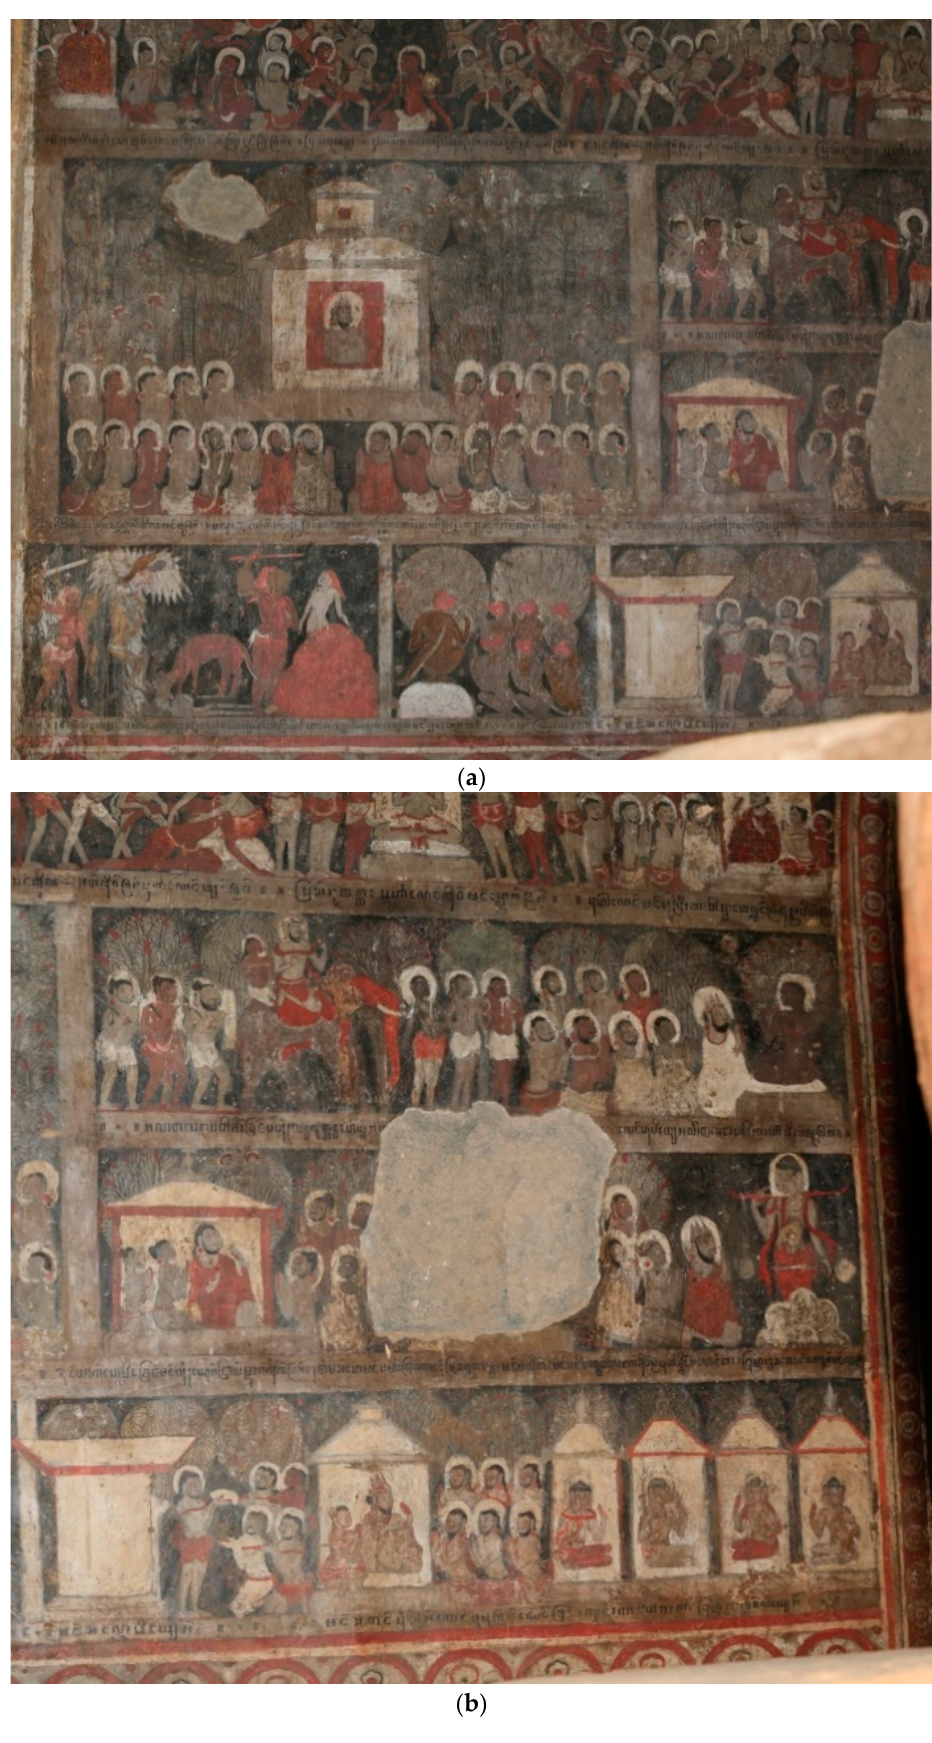
Figure 35. Pagan, Lokahteikpan, 12th century. N ā rada J ā taka. ( a ) First part of the Narada Jataka narrative. ( b ) Conclusion of the Narada Jataka narrative.